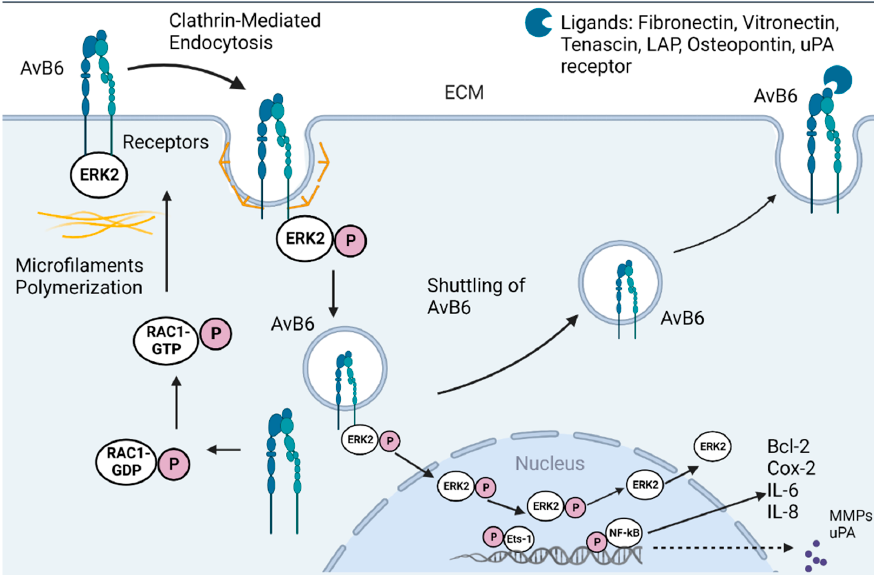
Figure 3. Schematic representation of the role of integrin α v β 6 in cancer. Clathrin-dependent endo- cytosis of integrin α v β 6 activates ERK signalling cascade. Activated ERK results in phosphorylation of Ets-1 and NF-kB pathway. This results in transcription and translation of MMPs, Bcl-2, uPA, and IL-6. The activated Ets-1, upon localizing in the nucleus, results in integrin α v β 6 transcription and eventual recycling within the tumour environment. This results in a positive feedback look and promotes cancer tumour proliferation and disease progression (modified [28]). Reprinted/adapted with permission from Ref. [28]. 2022, Elsevier.